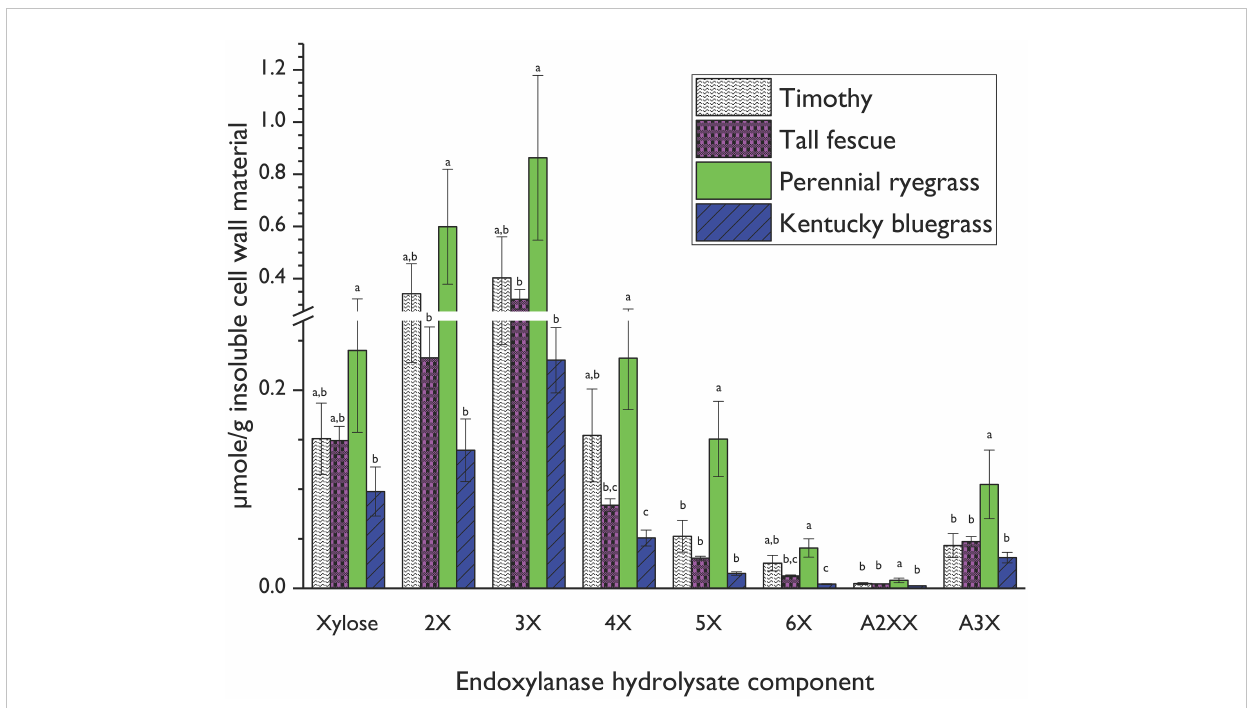
FIGURE 4 Xylooligosaccharide (XOS) and arabinoxylan oligosaccharide (AXOS) pro fi les of endoxylanase ( Cellvibrio japonicus ; GH 10) hydrolysates from timothy, tall fescue, perennial ryegrass and Kentucky bluegrass insoluble cell wall material. Data represent means and standard deviations of four biological replicates for all compounds, except for 3X from perennial rye grass and timothy and xylose from tall fescue (n=3 in these cases). Lowercase letters above error bars indicate results of statistical comparisons of the means between species for individual XOS and AXOS. When considering results for an individual XOS or AXOS, means lacking a common letter are different for that individual XOS or AXOS between species ( p < 0.05). Please refer to Figure 1 for chemical structures corresponding to standard compounds ’